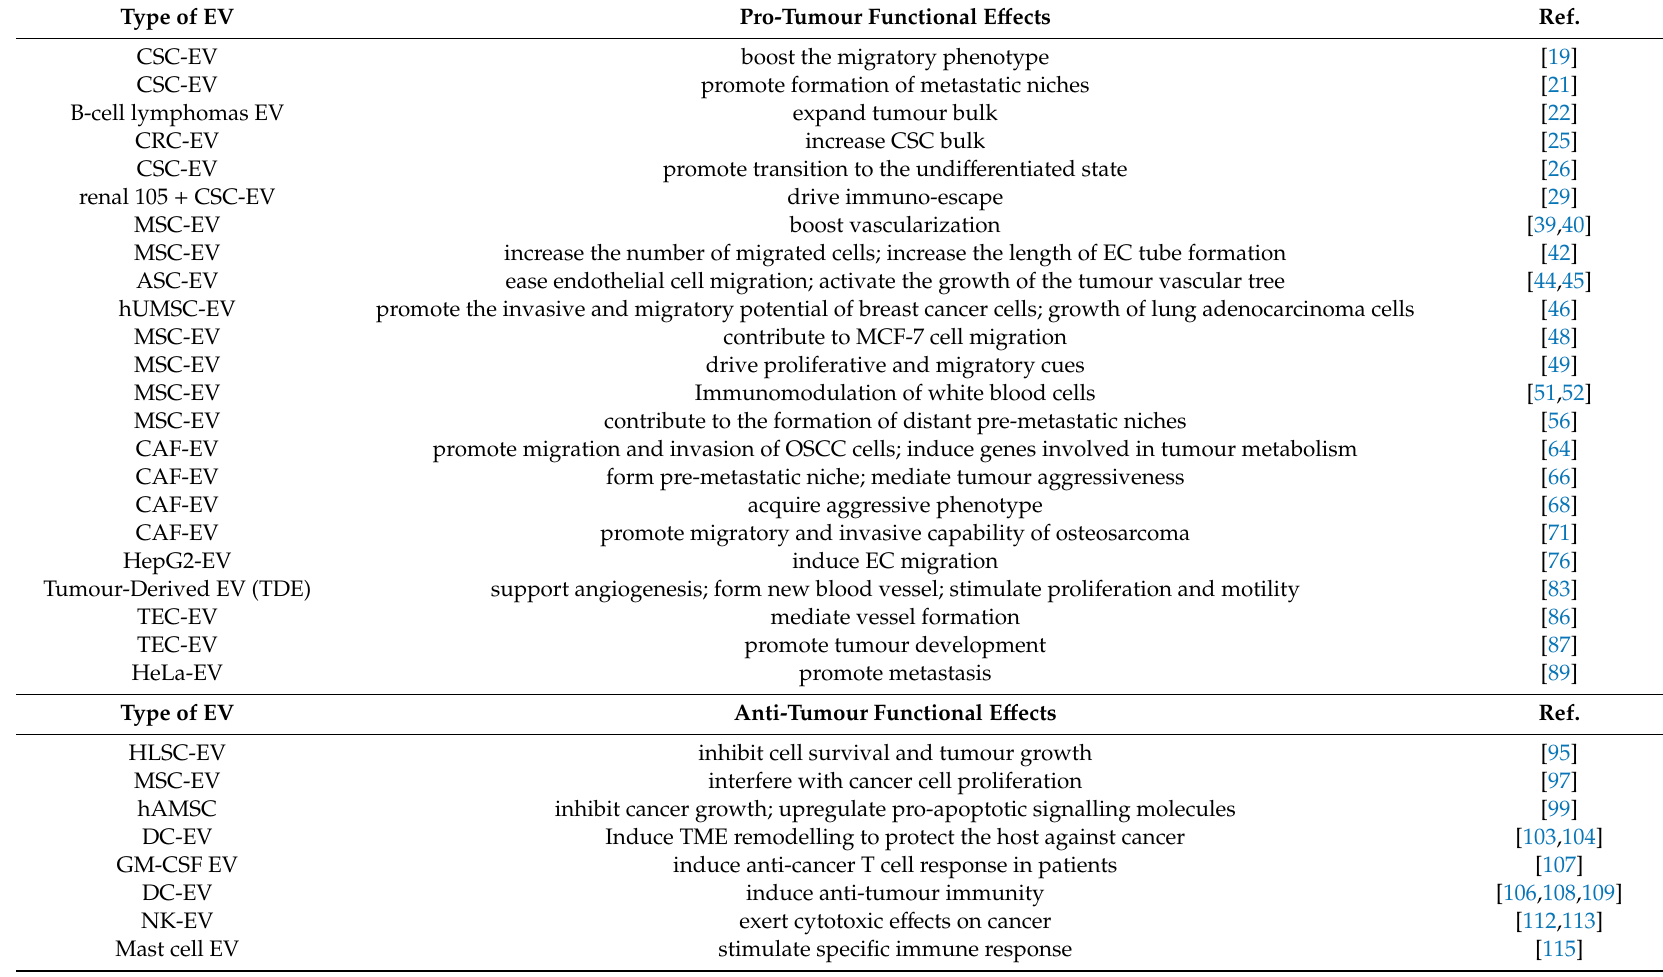
Table 1. Pro-tumour and anti-tumour functional e ff ects of